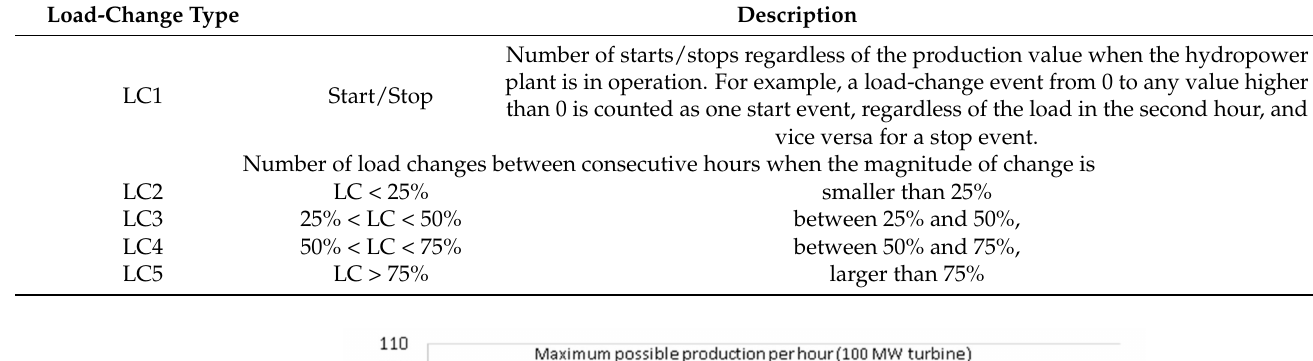
Table 1. Load-change types considered for analysis of production data.